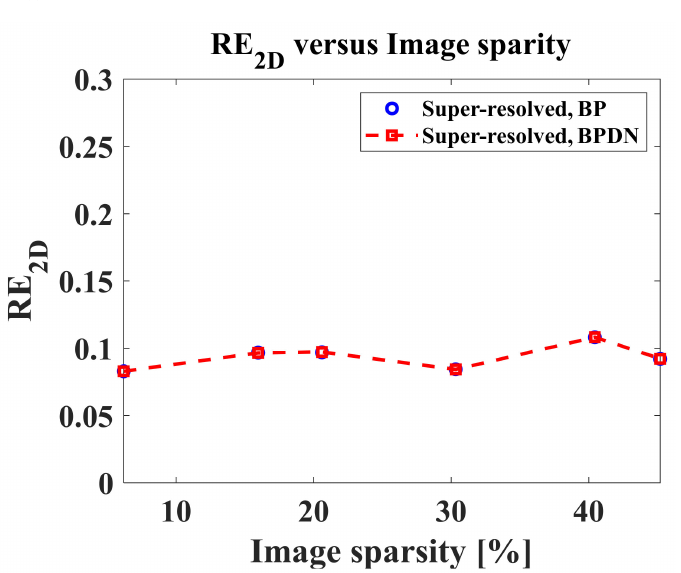
Figure 12. Target images of the extended static target having different χ : ( a ) χ = 6.18 % and ( b ) χ = 20.6 %.